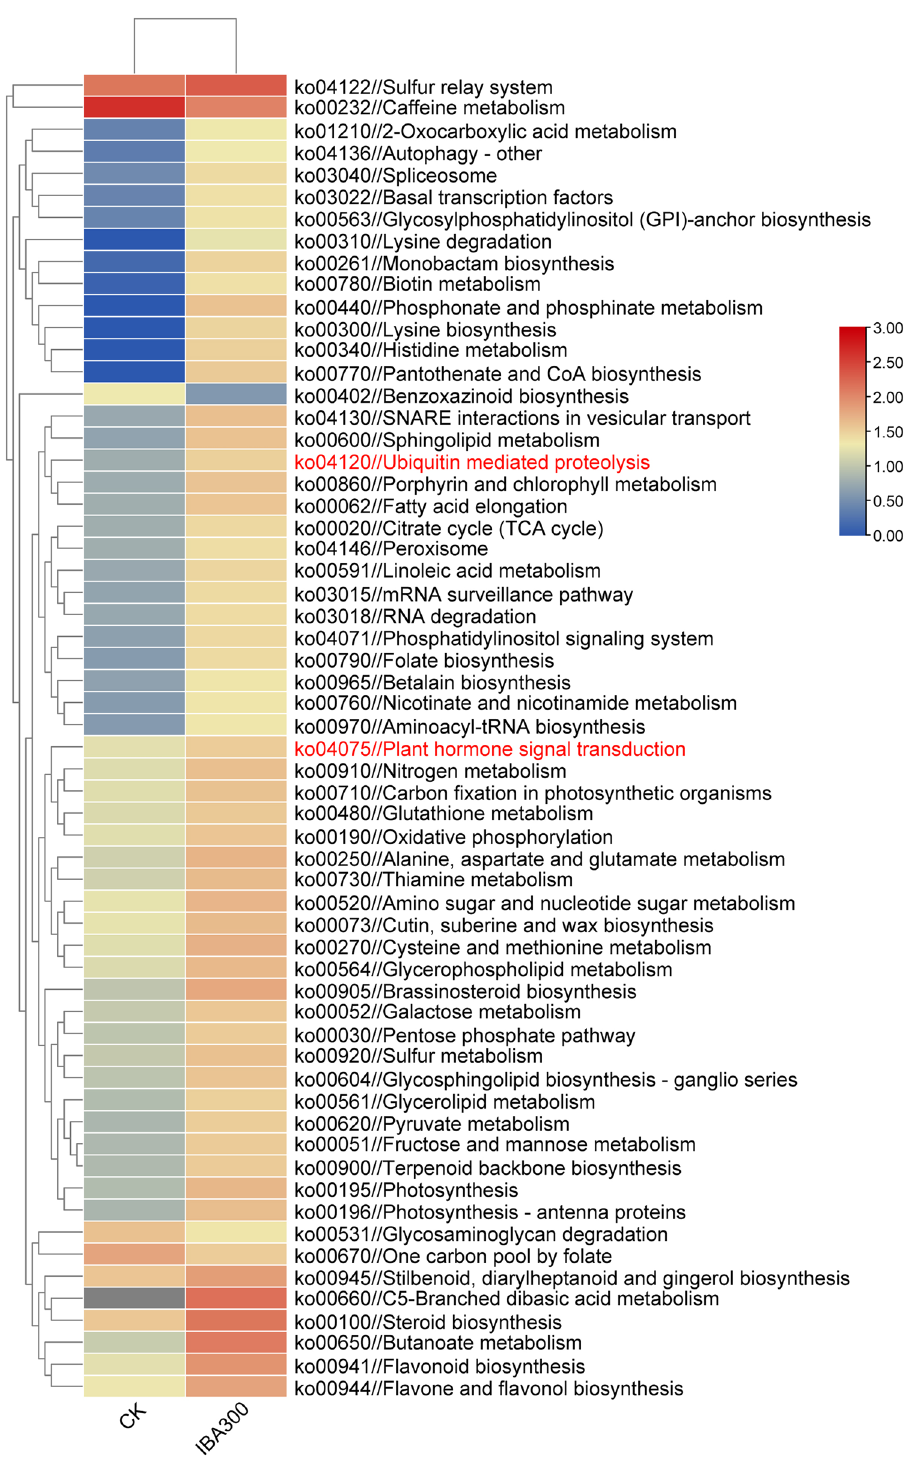
Figure 3. Hierarchical clustering of the differentially expressed genes associated with the major regulatory pathways. Bars represented scales of pathway expression levels (log 2), from upregulated (red) to downregulated